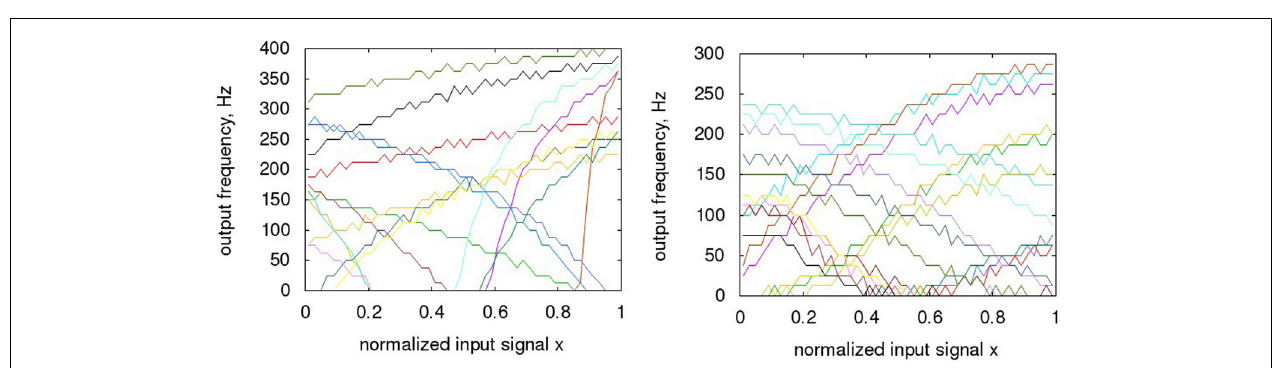
rates of the hardware neurons are actually at ca. 45MHz, which converts to 300Hz when the timescale is converted to the Nengo one. The normalized input range of the hardware neurons corresponds to rail-rail, i.e., GND to